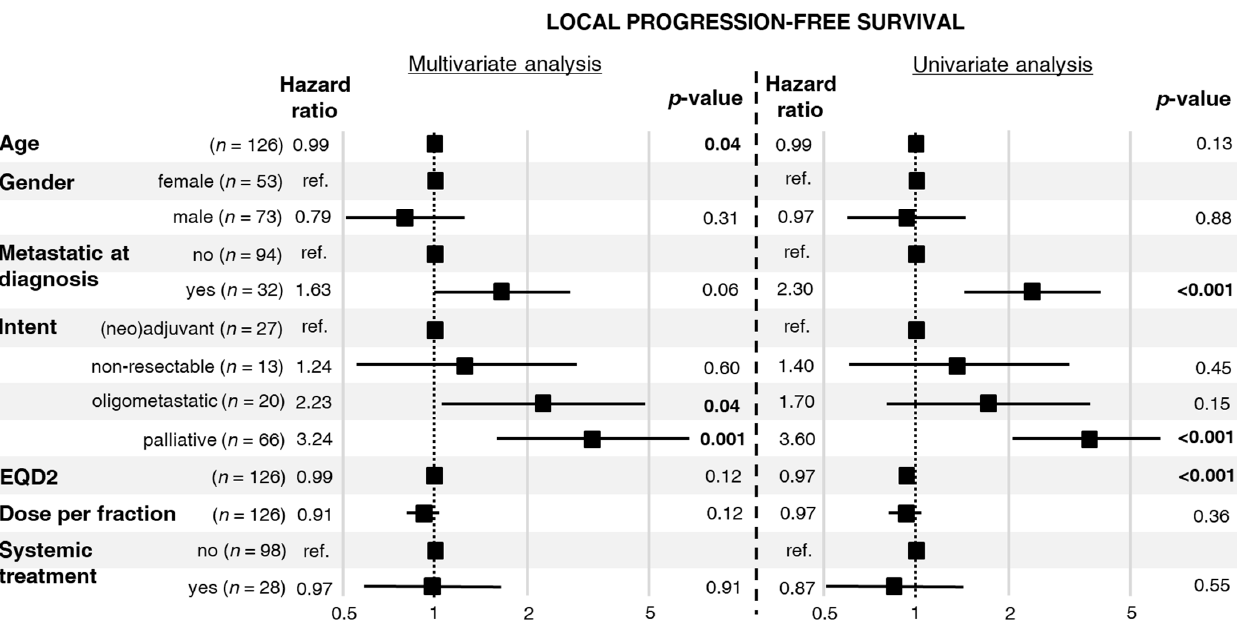
Figure 2. Hazard ratios for local progression or death with 95% confidence intervals and p -values calculated from a multivariate and univariate Cox proportional hazards model. Table 3. Occurrence of in-field local progression in patients who underwent non-palliative radiotherapy.